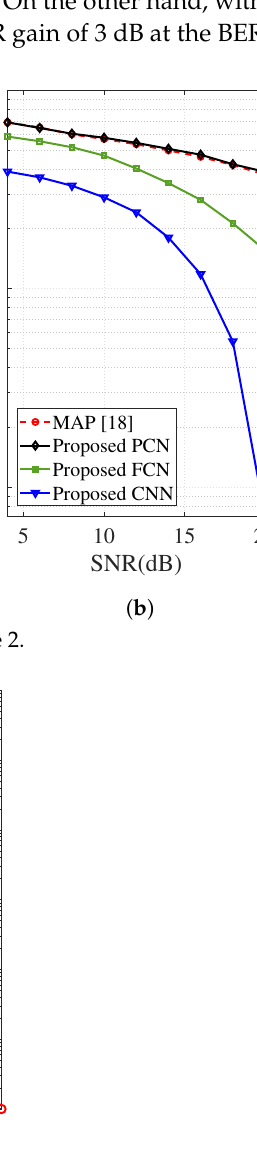
Figure 4. Comparison of BERs for Case